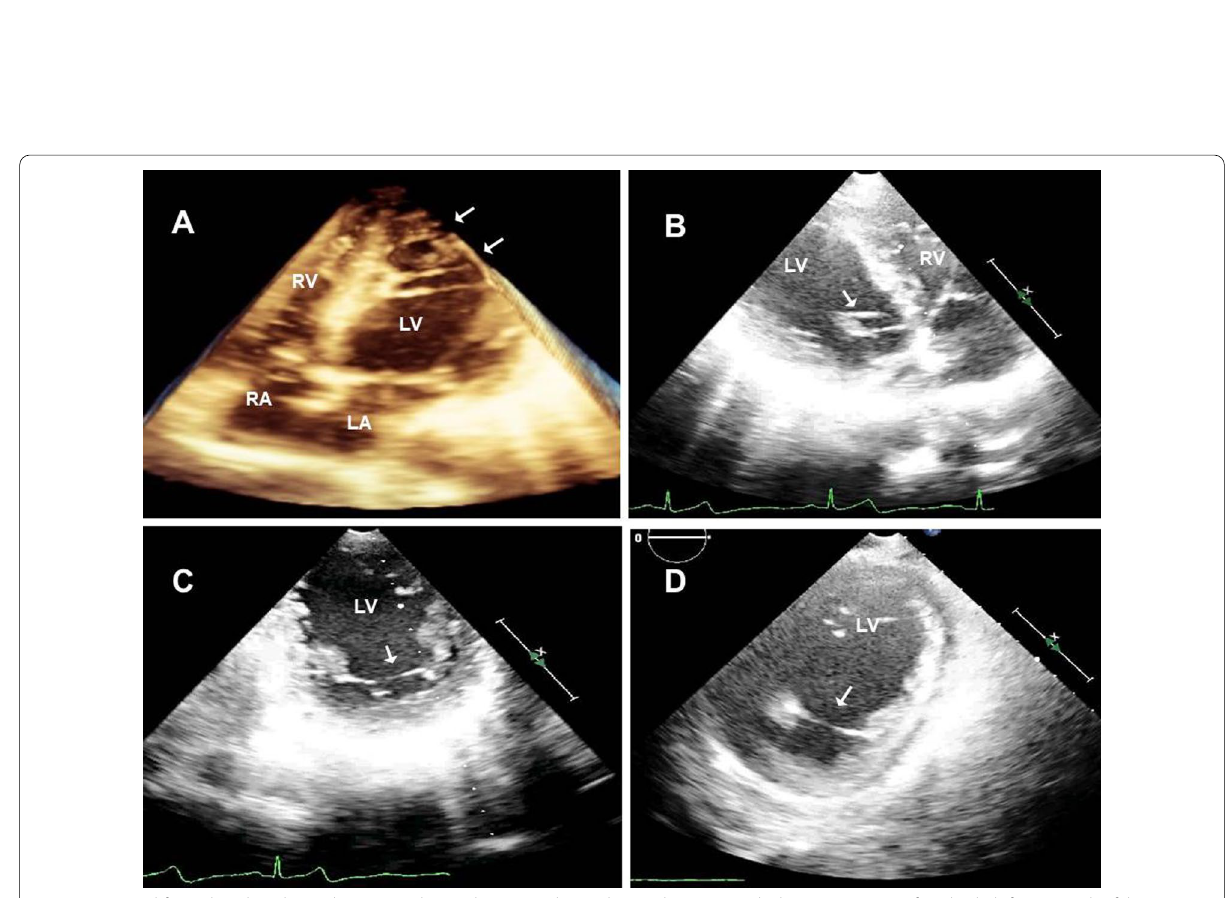
Fig. 2 A Apical four-chamber three-dimensional transthoracic echocardiographic view with the appearance of multiple left ventricular false tendons (arrows). B Modified Four-chamber long-axis view depicting two left ventricular false tendons (arrow) from anterolateral mitral papillary muscle to basal segment of the anterior septal wall. Left ventricular false tendons are restricting the movement of the papillary muscle by pulling toward to interventricular septal wall. Fortunately, mitral valve dysfunction did not emerge secondary to these lesions. C , D Modified apical two-chamber view revealed complex branching left ventricular false tendons (arrow) between the base of anterolateral and posteromedial mitral papillary muscles and chordae